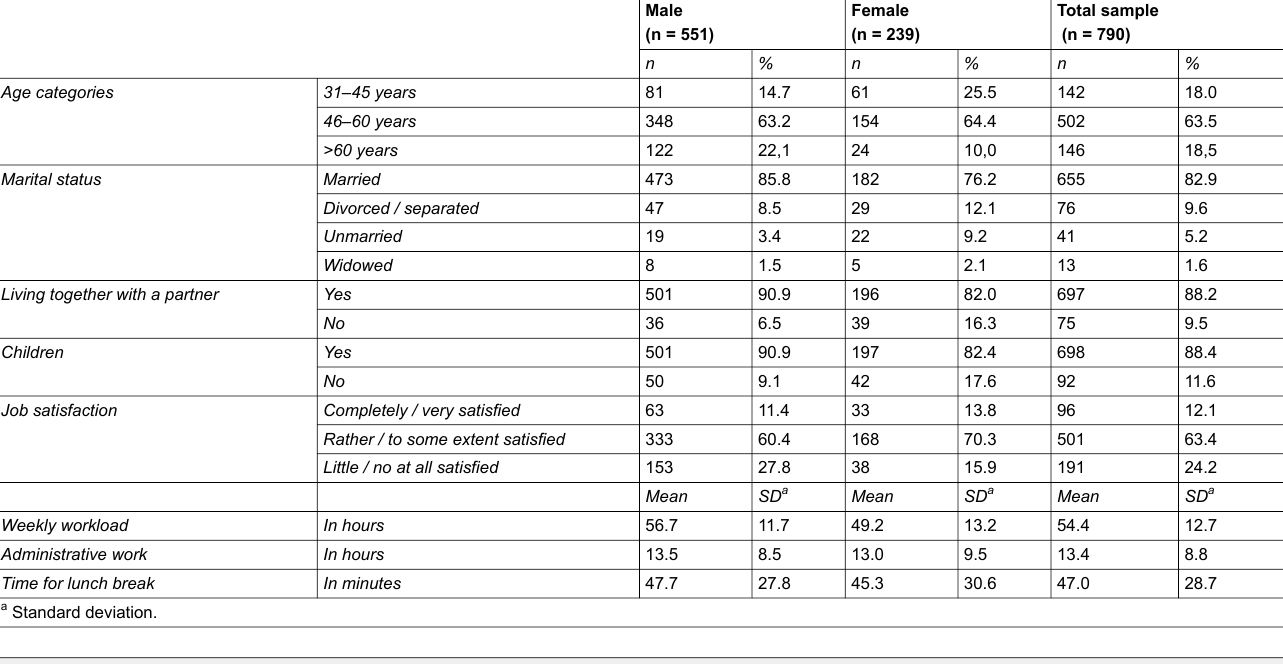
Table 2: Socio-demographic and work-related characteristics of the sample (n = 790, missings included).